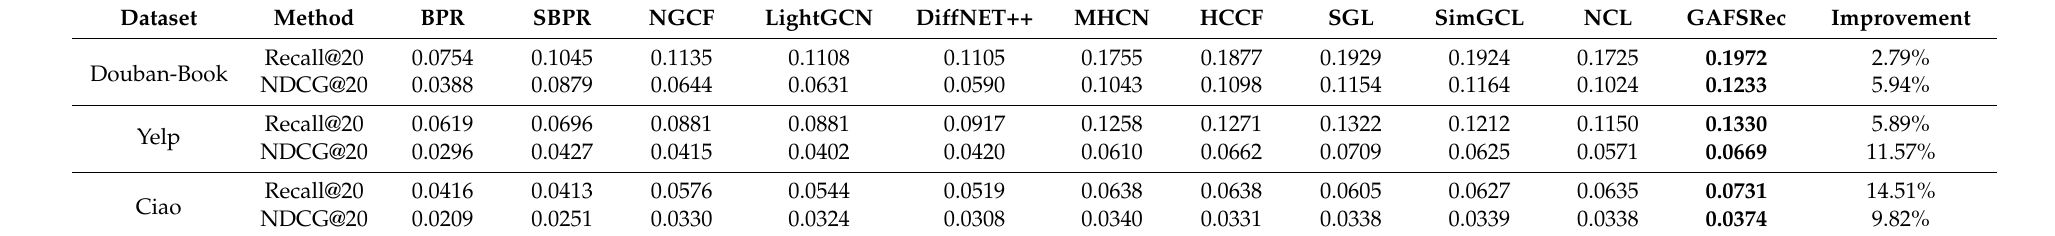
Table 4. Cold-start recommendation performance